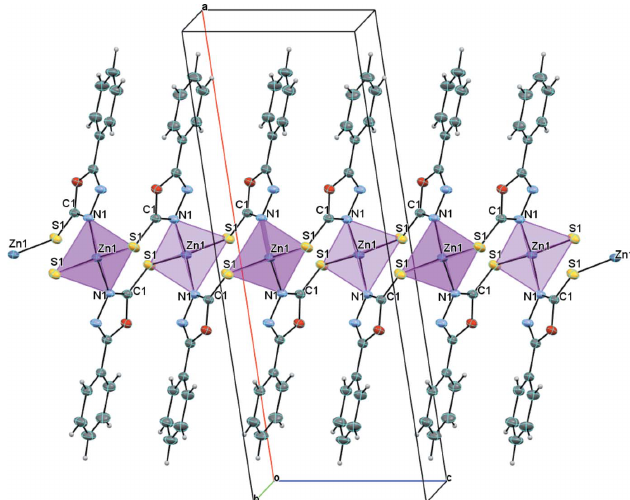
Figure 2 The view of the molecular packing showing the polymeric chain extended along the c -axis.